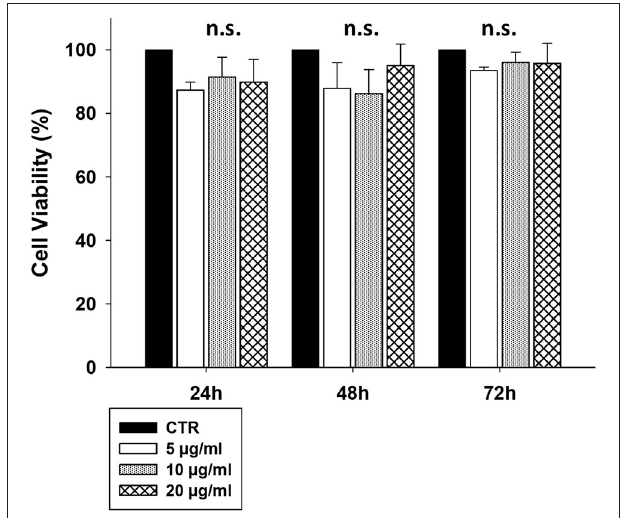
FIGURE 2 | CaCo-2 cells viability after CS-EVs treatment. Cell viability was assessed by MTT assay at 24, 48, and 72h after incubation with 5, 10, or 20 µ g/ml of CS-EVs. Each histogram represents the mean ± SD of three independent